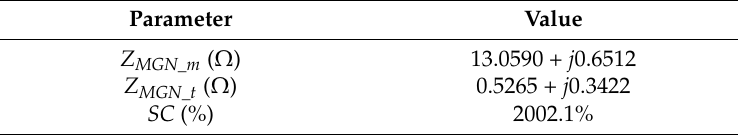
Table 5. Estimation results of Z MGN_m and SC .